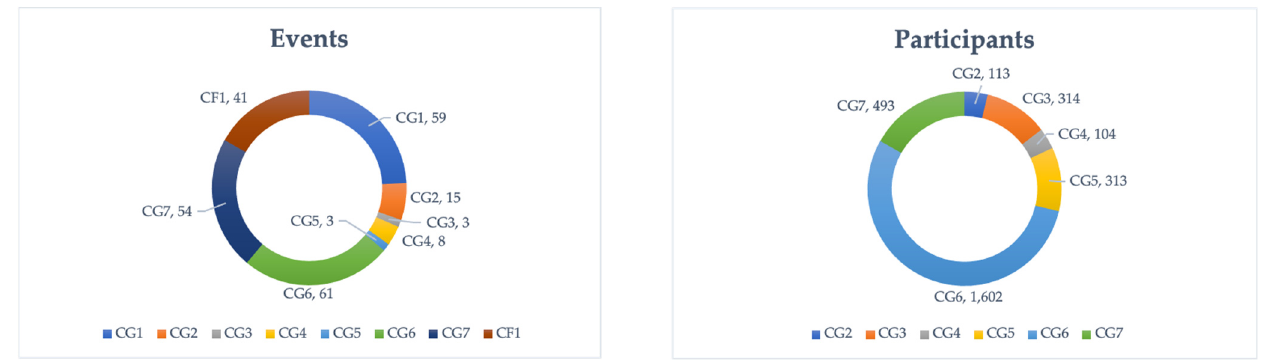
Figure 10. Events and participation in the case study